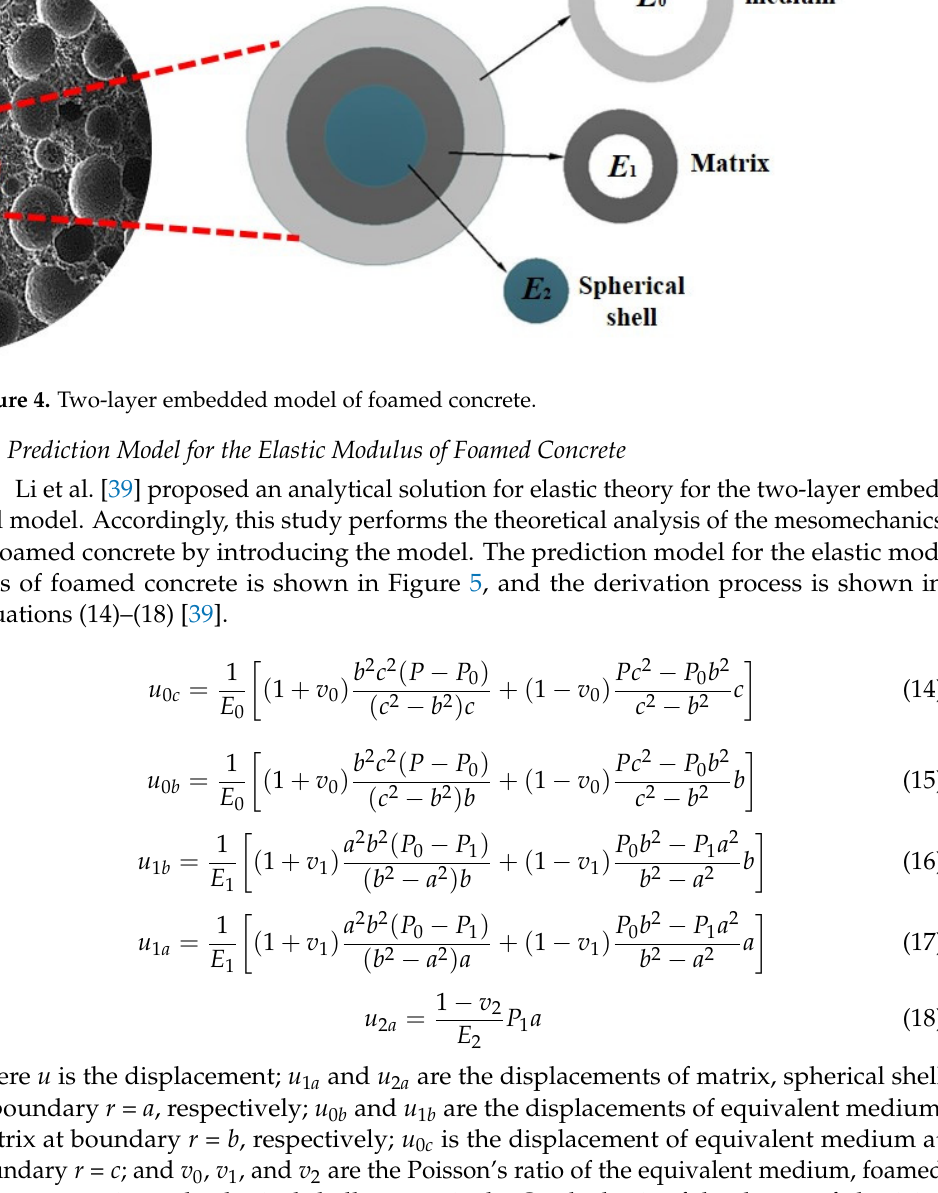
Figure 5. Prediction model for the elastic modulus of foamed concrete.